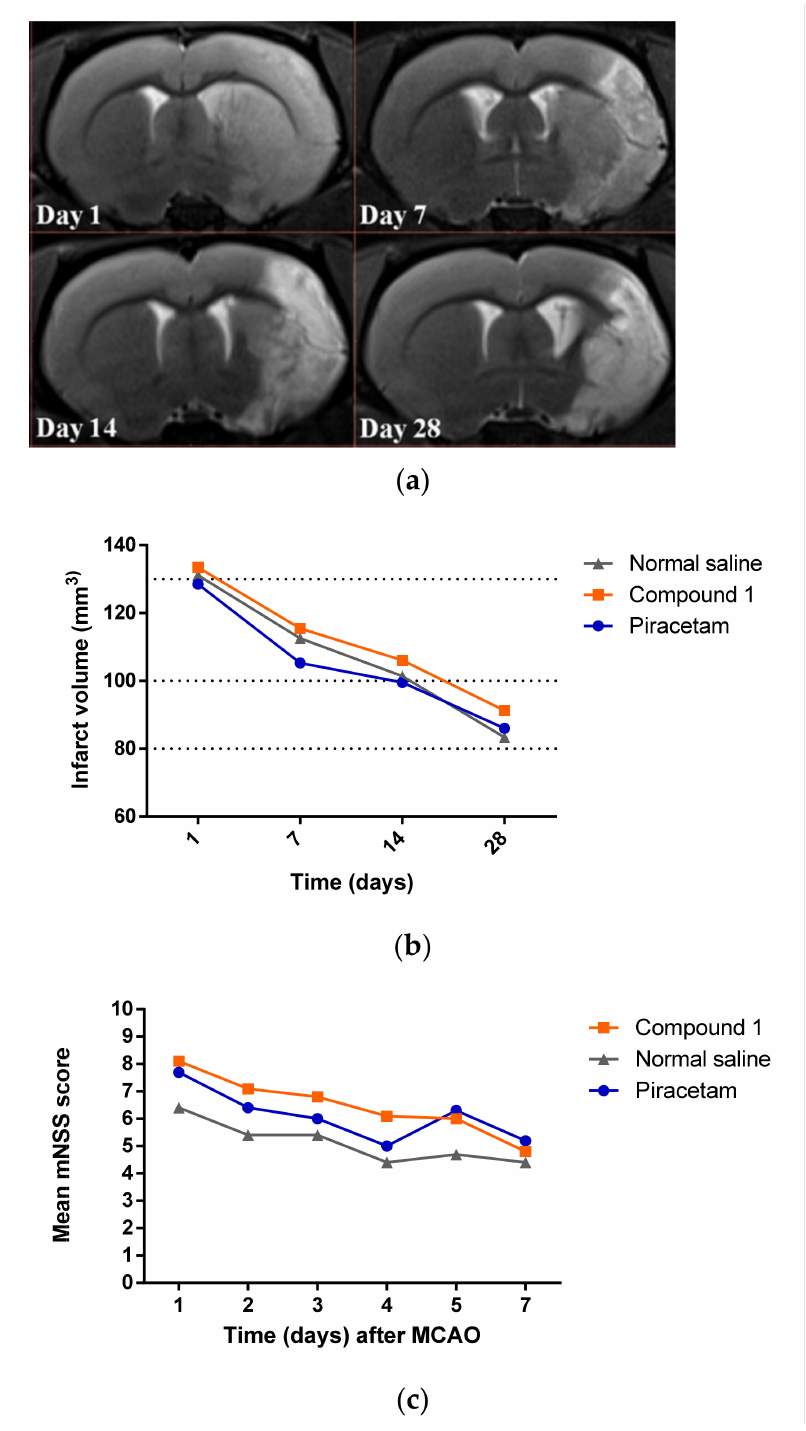
Figure 3. ( a )—T2-weighted MRI images of the rat brain on postoperative days 1, 7, 14, and 28. The hyperintense zones correspond to ischemic lesions; ( b )—infarct volume in mm 3 at different time points after MCAO (24 h) and treatment initiation (days 7, 14, 28); ( c )—mean mNSS score after MCAO in rats treated with compound 1 , piracetam, and normal saline. There were no statistically significant differences observed between the three